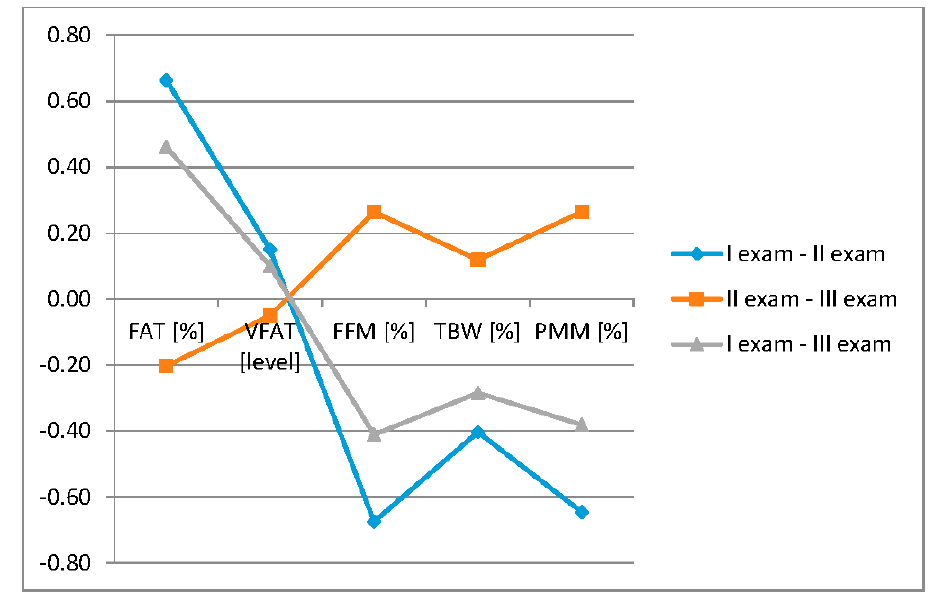
Figure 5. The changes of body mass components during the time.